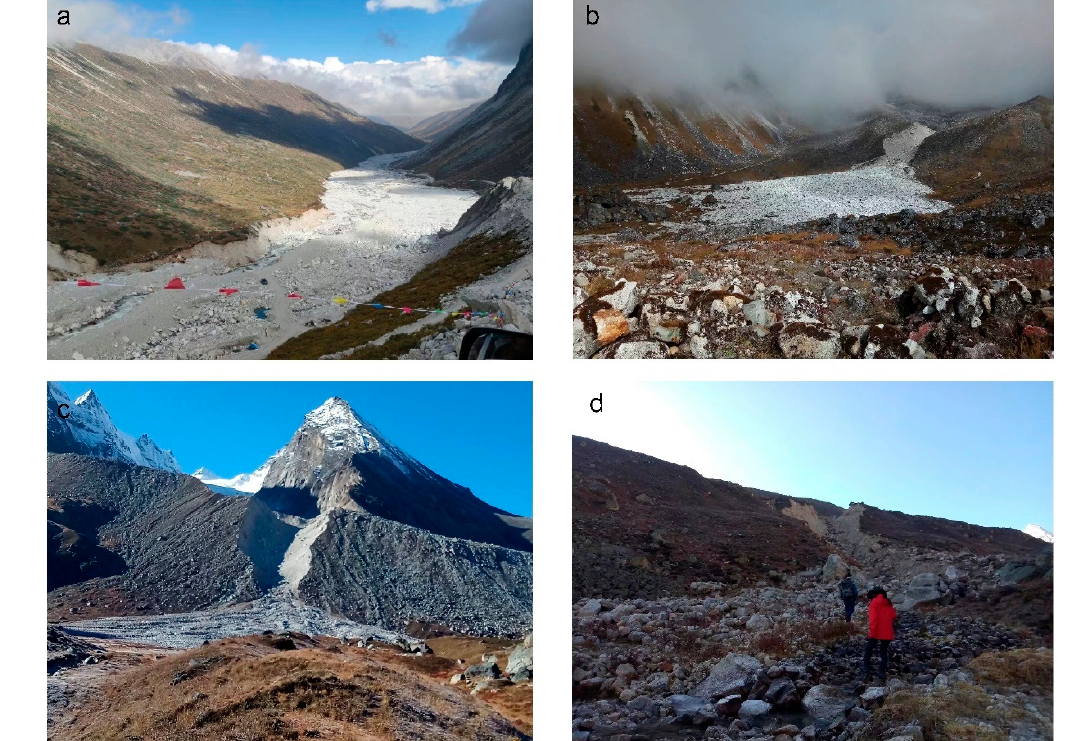
Figure 2. These photos demonstrate a distinct relationship between the shape of the breach and the eroded riverbed of GLOFs. A field investigation allowed us to observe flood traces at ( a ) Jialongco, ( b ) Gongbatongshaco, and ( c , d ) an unnamed lake reported by Veh et al. [46].